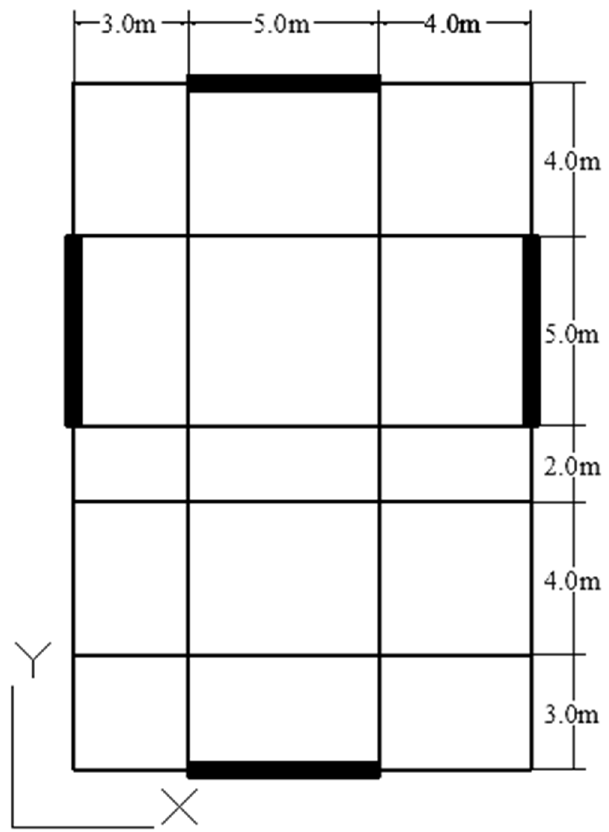
Figure 1. The plan of the buildings with the locations of the shear walls.